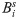
Structural and functional balance.Colour coded map of the countries in the ITN for (a) structural balance Bis and (b) functional balance Bit. The majority of countries are in the [−1, −0.75] region indicating that most tourism is outgoing in nature. The countries for which we have no tourism data are represented in grey. This figure was created by using the open-source software Gephi, which is distributed under CDDL 1.0 and GNU General Public License v3 [35].